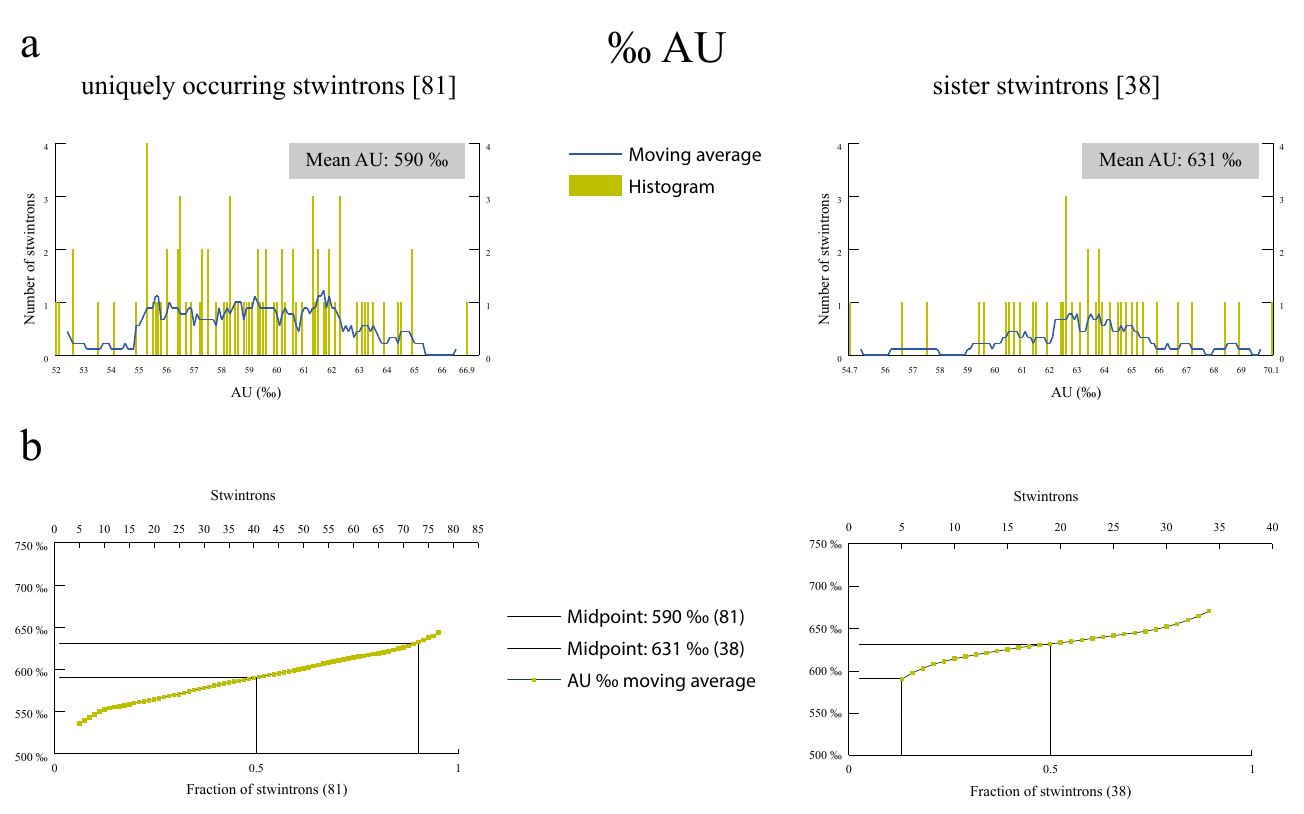
Figure 5. The AU content of sister stwintrons is consistently higher than that in the miscellaneous group of evolutionary older, uniquely occurring stwintrons. ( a ) shows the crude data in histogram form specifying the number of stwintrons with one particular AU content rounded to units permille (‰). A moving average of the AU content over a window of nine consecutive permillages (number of AU/number of nt for each stwintron × 1000) was calculated for single step increments in AU content (blue line). In ( b ), incrementing moving averages of AU content (green data points) were plotted against the fraction of stwintrons for each of the two groups. The mean AU content in each group of stwintrons (permillage AU at stwintron fraction 0.5) was indicated with horizontal and vertical lines in both